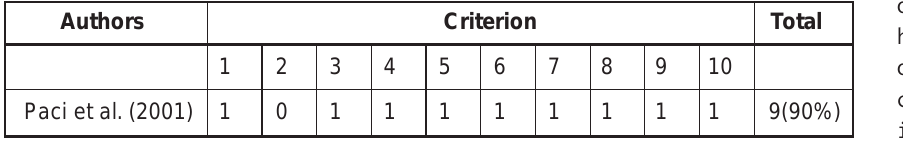
Table 4: Crombie Scale: Observational